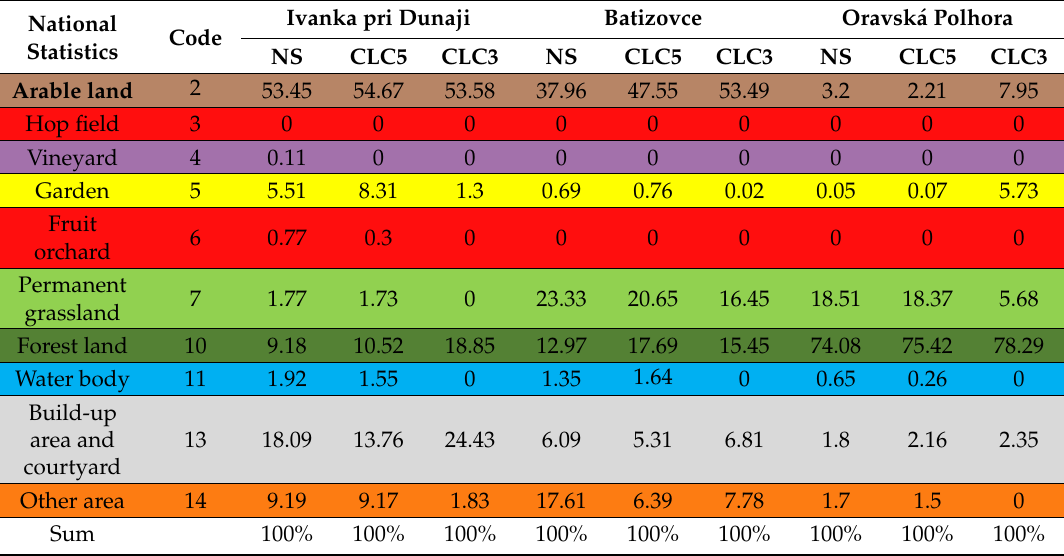
Table 4. Comparison of NS, o ffi cial CLC data (CLC3) and outputs of the newly proposed methodology for detailed mapping of LC (CLC5) for case studies of municipalities in